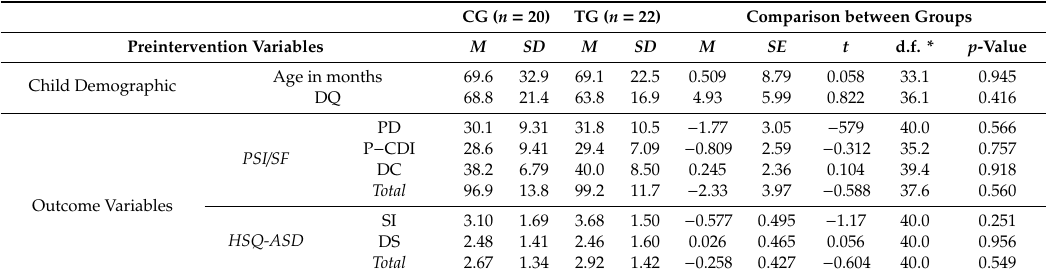
Table 1. Demographic and clinical characteristics of the